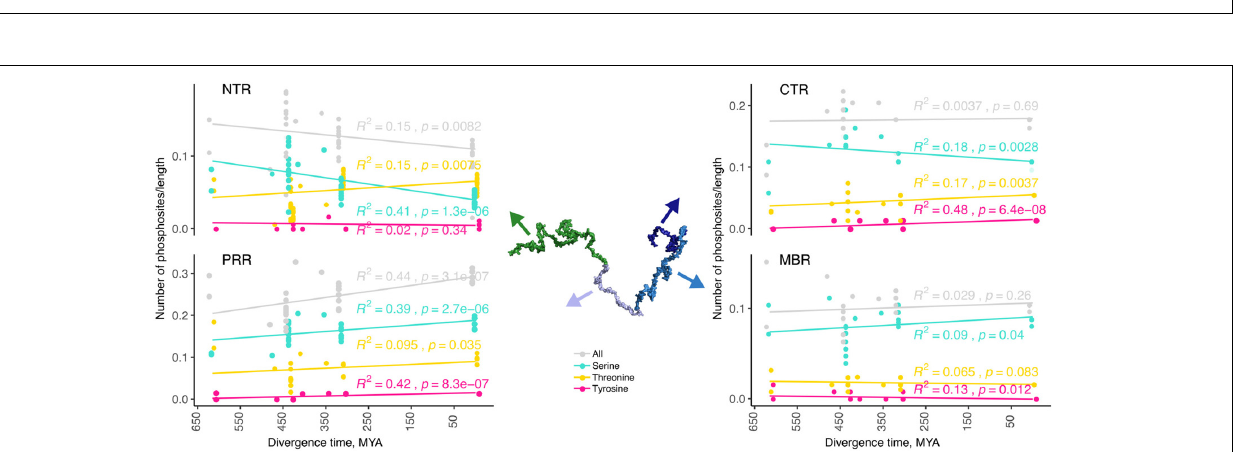
Phosphorylation occurs at three different residues, NetPhos3 phosphorylation prediction server to obtain numbers of sites that could be phosphorylated with high